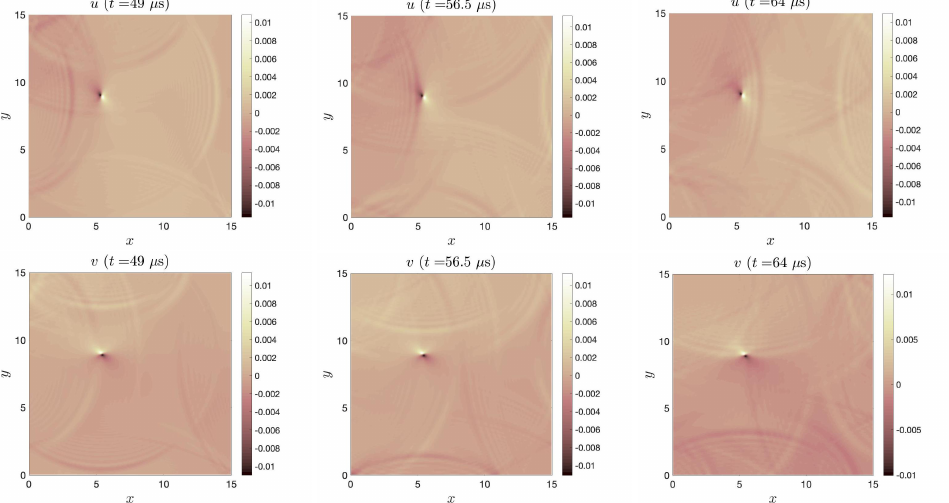
Figure 4. Components of the displacement vector u ( top ) and v ( bottom ) at times t = 49, 56.5 and 64